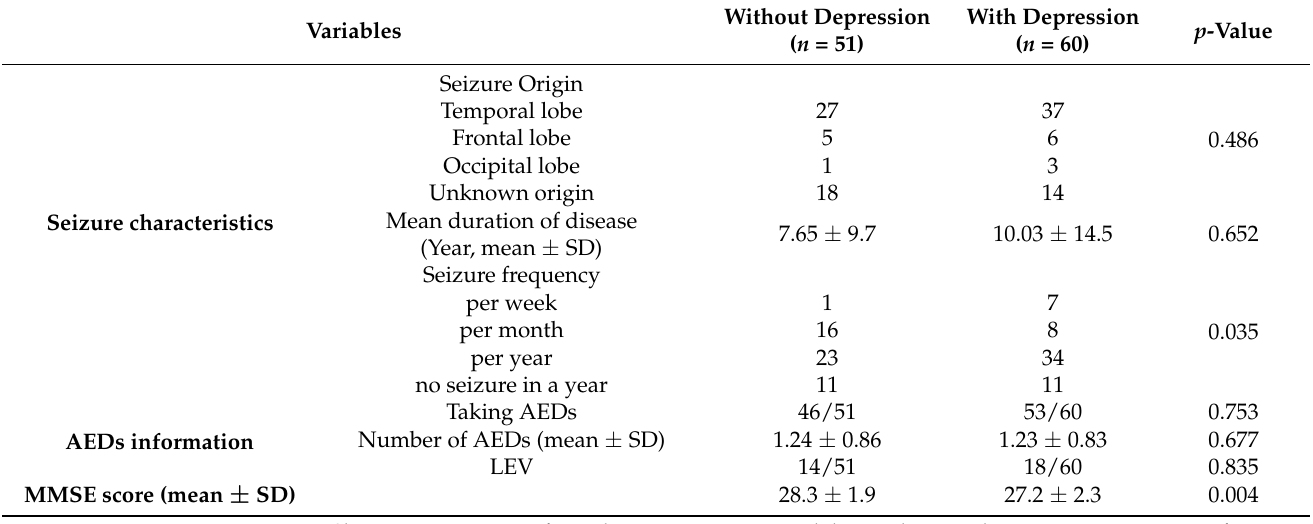
Table 2. Comparisons of clinical characteristics between PwE with and without depression